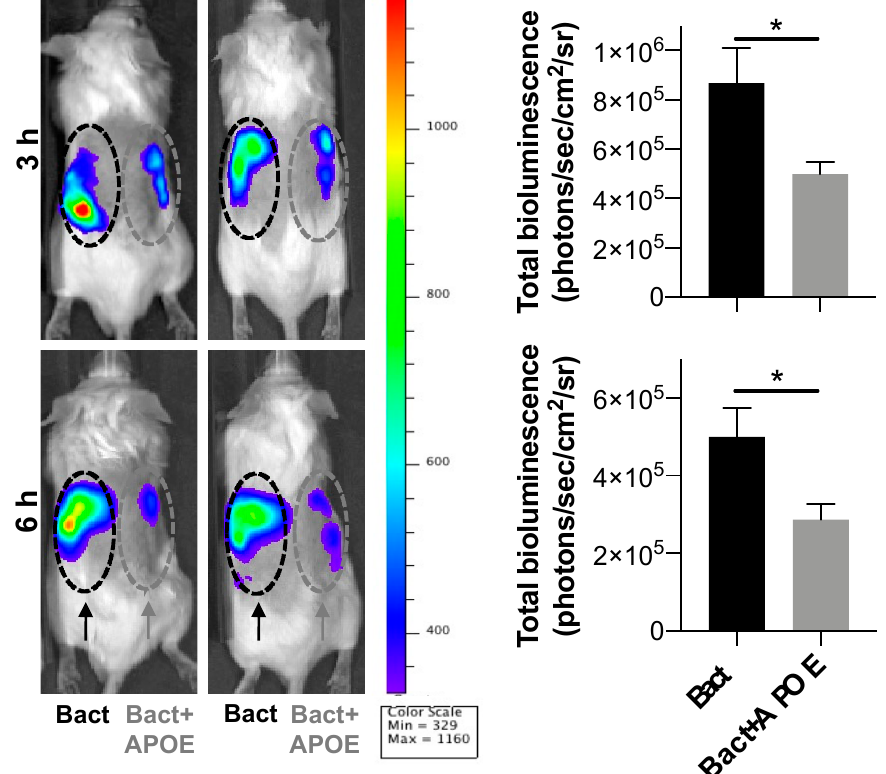
Figure 8. Anti-endotoxic effect of APOE in vivo. NF- κ B activation in the NF- κ B-RE-luc random transgenic mouse model was analyzed by the IVIS imaging. Heat-killed bacteria PAO1 (1 × 10 6 cfu) (left side of the dorsum) or heat-killed bacteria (1 × 10 6 cfu) treated with APOE (2 µ M) (right side of the dorsum) were injected subcutaneously and the NF- κ B response was longitudinally imaged 3 and 6 h after the subcutaneous injection. Representative images show bioluminescence at 3 and 6 h after subcutaneous injection. Bar charts show bioluminescence measured from these reporter mice. Data are presented as the mean ± SEM ( n = 5). p value was determined using an unpaired t -test. * = p ≤ 0.05.